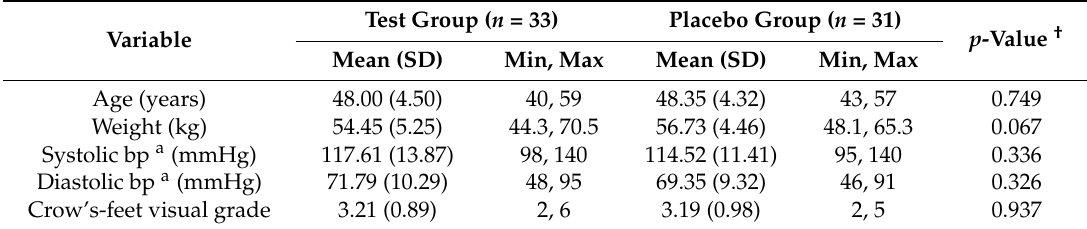
Table 3. Baseline characteristics of participants.